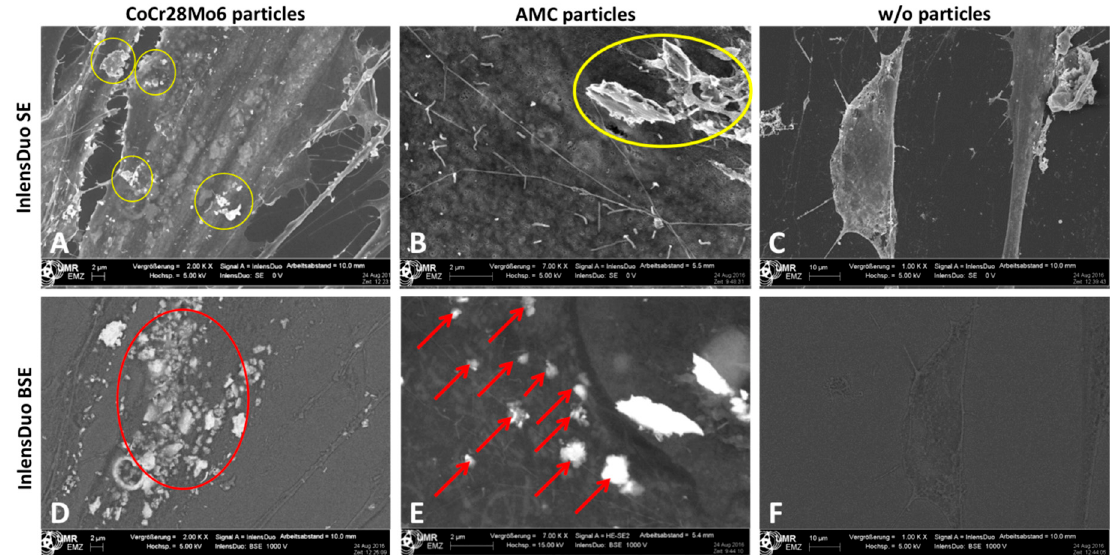
Figure 6. Human primary fibroblasts exposed to CoCr28Mo6 ( A , D ; scale bar: 2 µm) and AMC ( B , E ; scale bar: 2 µm) particles in comparison to unexposed cells ( C , F ; bar: 10 µm) analyzed with different Inlens Duo detector settings at 5 kV accelerating voltage. ( A – C ) Using the Inlens Duo SE detector, particles on the upper surface of the cell membrane were clearly visible (yellow circles). ( D – F ) Using the Inlens Duo BSE detector particles in the deeper region under the cell membrane were clearly visible (red arrows/circle). ( C , F ) No particles were detected by both InlensDuo detectors.